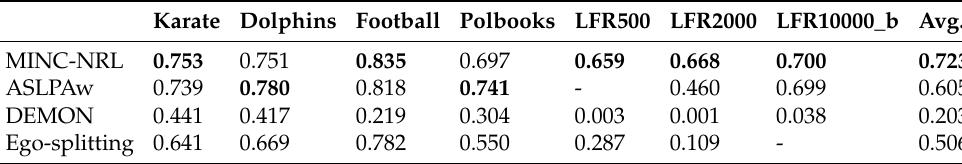
Table 7. Q ov of MINC-NRL compared with other algorithms.